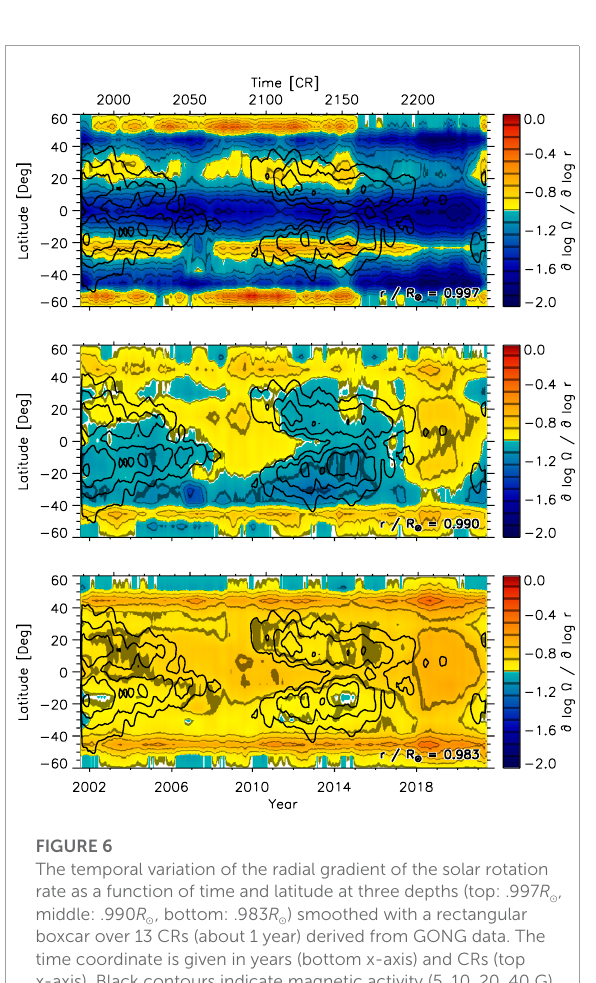
FIGURE 6 The temporal variation of the radial gradient of the solar rotation rate as a function of time and latitude at three depths (top: .997 R ⊙ , middle: .990 R ⊙ , bottom: .983 R ⊙ ) smoothed with a rectangular boxcar over 13 CRs (about 1 year) derived from GONG data. The time coordinate is given in years (bottom x-axis) and CRs (top x-axis). Black contours indicate magnetic activity (5, 10, 20, 40 G) smoothed over five CRs.